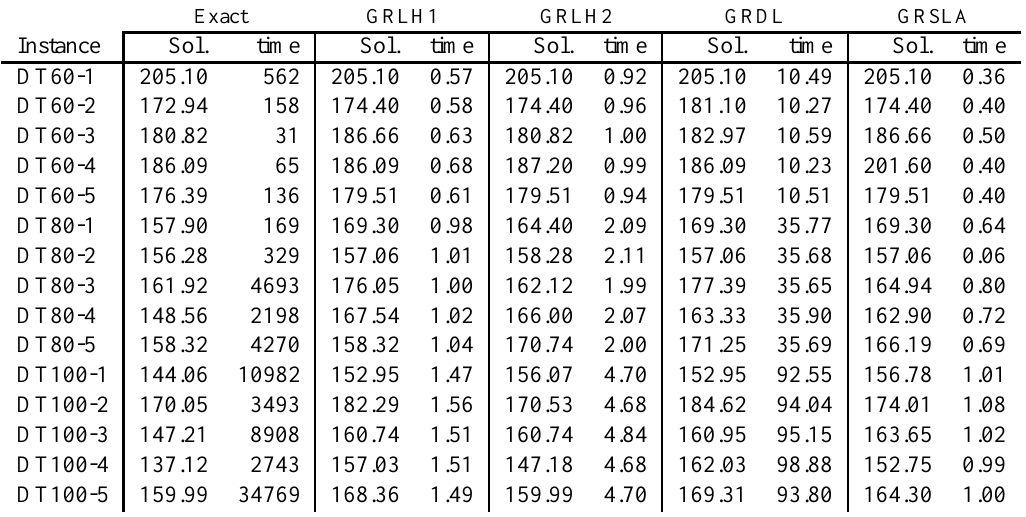
Table 14. Results for small instances.